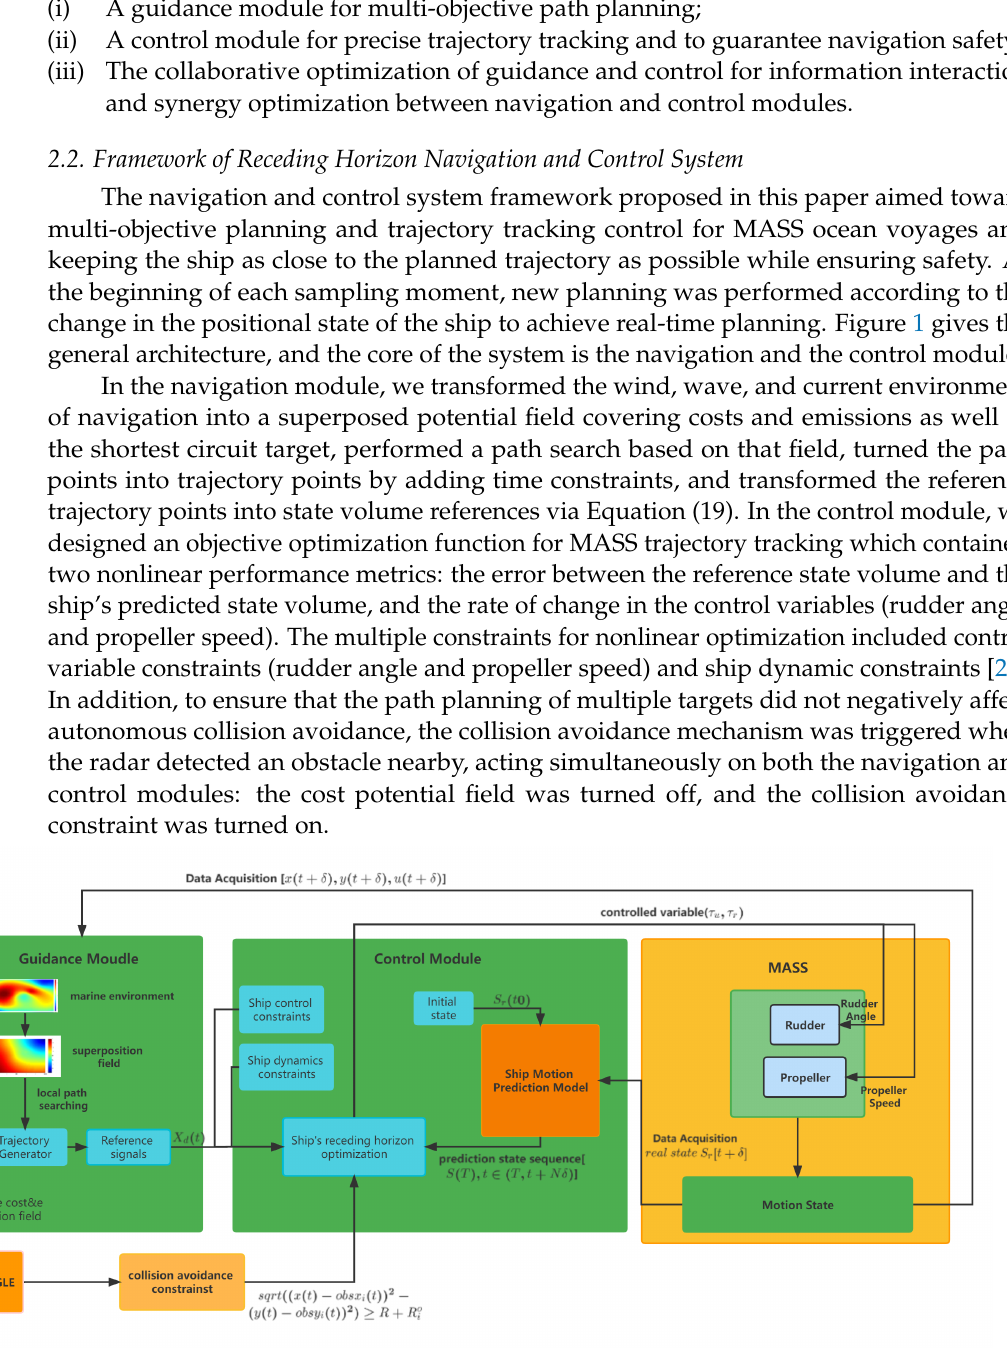
Figure 1. Technical structure of receding horizon navigation and control